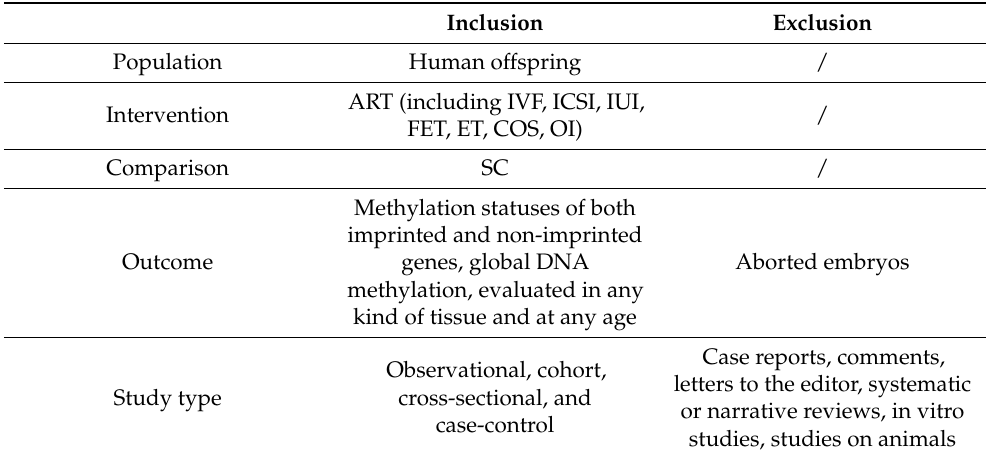
Table 1. Inclusion